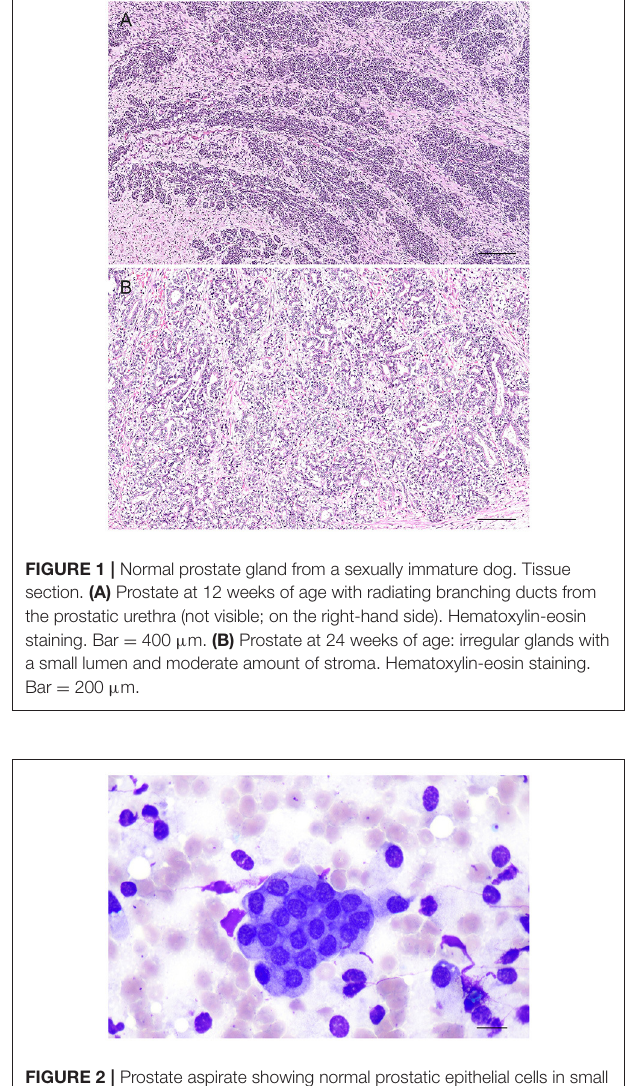
FIGURE 2 | Prostate aspirate showing normal prostatic epithelial cells in small cluster with centrally located nuclei, finely stippled or reticular chromatin pattern and finely granular cytoplasm. Prostate fine needle aspirate (FNA), smear. Wright-Giemsa stain. Bar = 12 µ